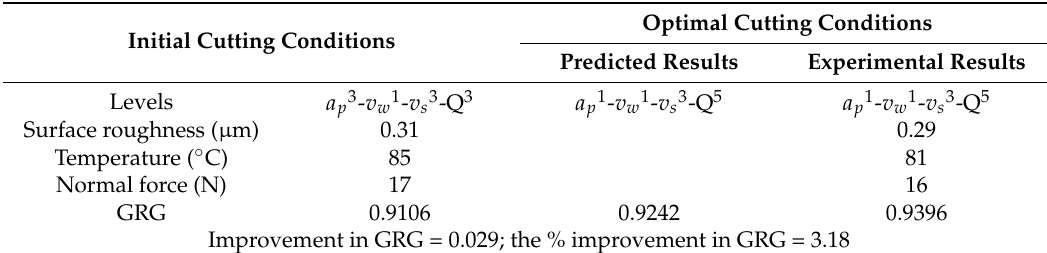
Table 7. Confirmation